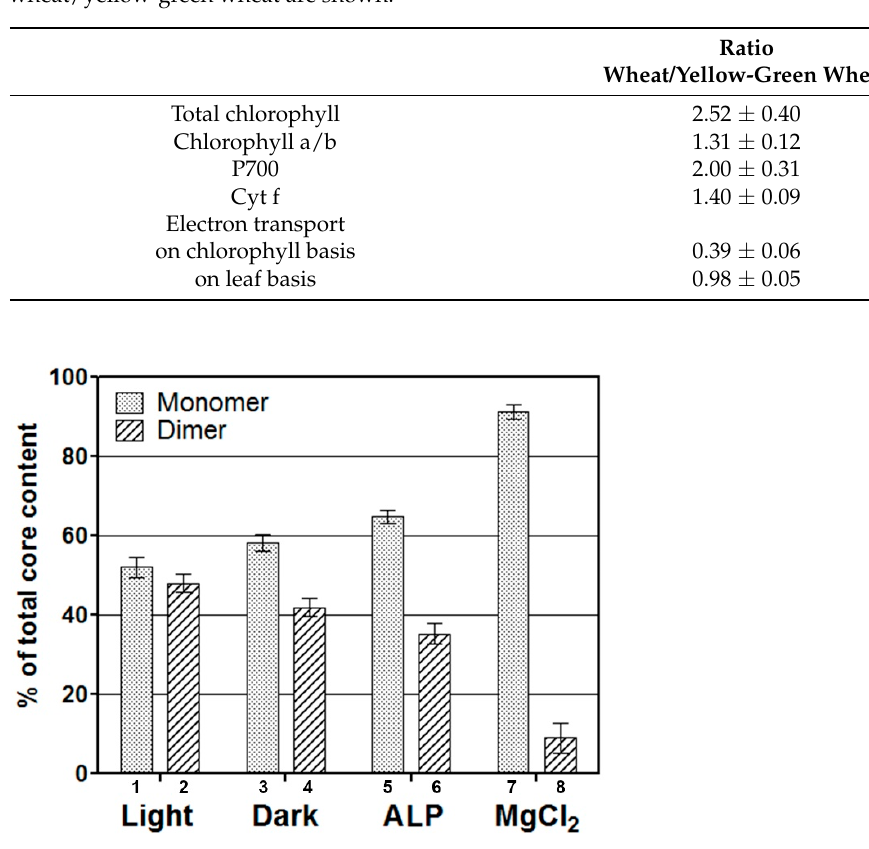
Figure 2. The photosystem II core population distribution in a sucrose gradient of solubilized pea PSII particles. PSII particles were isolated from ambient light and 8 h dark-adapted plants in the presence of a very faint green light (columns 1–2 and 3–4). Columns 5 and 6, particles treated with alkaline phosphatase (ALP). Columns 7 and 8, PSII particles isolated with a buffer containing MgCl 2 (0.5 mM). The core distribution was measured as the percentage of chlorophyll (Chl) relative to the total chlorophyll in the cores. The values for Chl distribution are an average of three determinations. Six independent experiments were